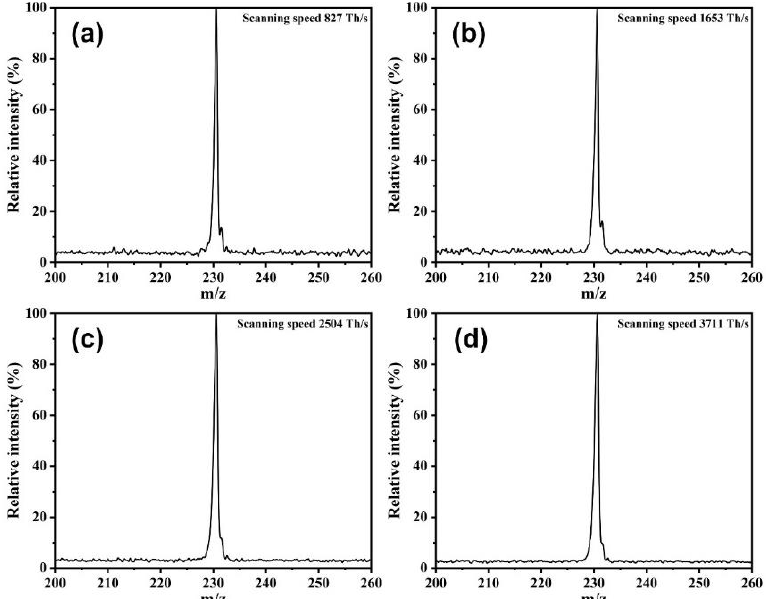
Figure 4. ( a ) Mass spectrum of butyl diacetate at scanning speed of 827 Th/s. ( b ) Mass spectrum of butyl diacetate at scanning speed of 1653 Th/s. ( c ) Mass spectrum of butyl diacetate at scanning speed of 2504 Th/s. ( d ) Mass spectrum of butyl diacetate at scanning speed of 3711 Th/s.